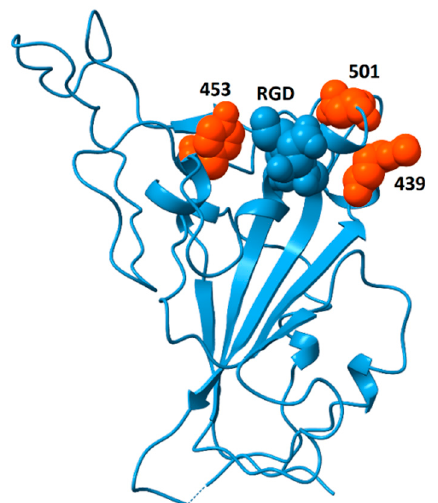
Figure 9. Spike protein receptor binding domain showing the location of residues N439, Y453 and N501 (orange) surrounding the RGD motif (blue, space-fill). The double mutant Δ 69/ Δ 70 often co-occurs with single-amino-acid replacements at these locations (N501Y, N439K and Y453F). Although residues 439 and 501 participate in ACE2-binding, Y453 does not [71]. This model is from pdb file 6M0J, in which the receptor-binding domain is bound to the ACE2 receptor (receptor not shown). Structural models in which the receptor-binding domain is unbound generally do not contain coordinates for residue 501 due to flexibility of the peptide chain between residues 499 and 504. The strategic location of this residue suggests that substitutions at this site could impact the availability of the RGD motif for binding to integrins.